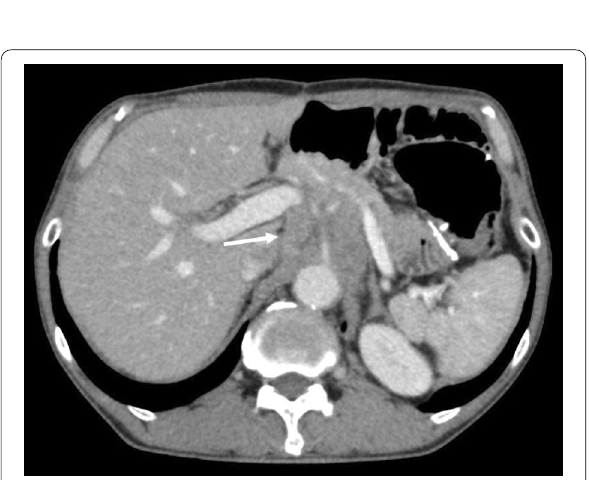
Fig. 2 After two courses of capecitabine metastatic lymph node was 47 mm